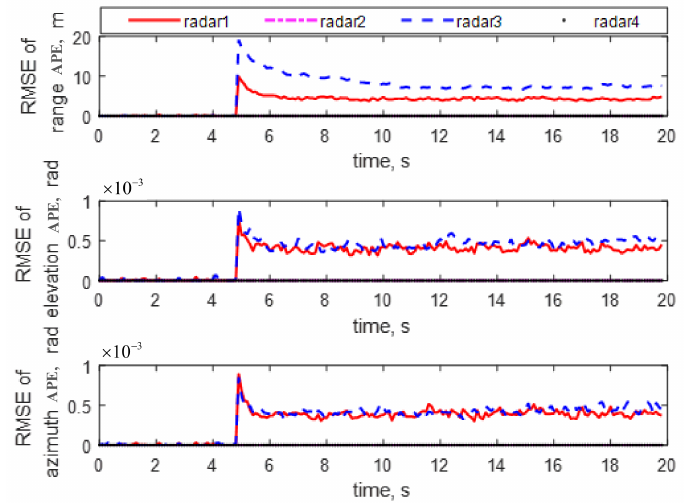
Figure 3. RMSE of the attack parameter estimations for radars